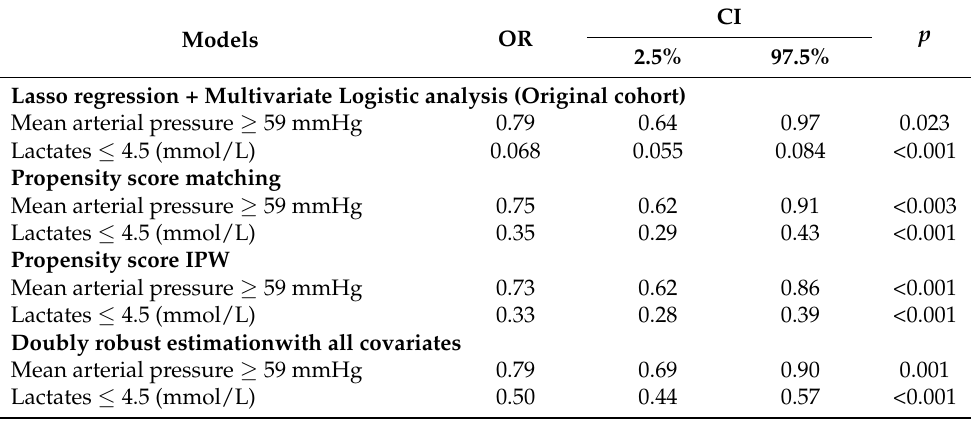
Table 3. Multiple models analysis of hemodynamic index to 28-day mortality in sepsis with encephalopathy. Models